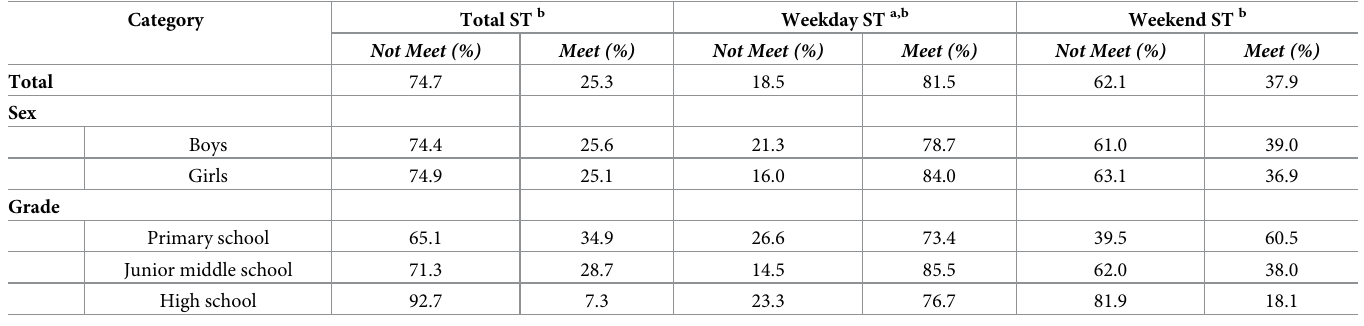
Table 2. Prevalence of meeting screen time